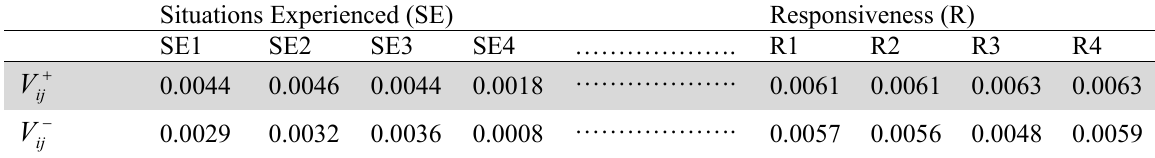
Stage 7: Determination of the positive ideal and negative ideal solutions The positive ideal solutions and negative ideal solutions (11) respectively as shown in Table 11. The positive ideal and negative ideal solutions